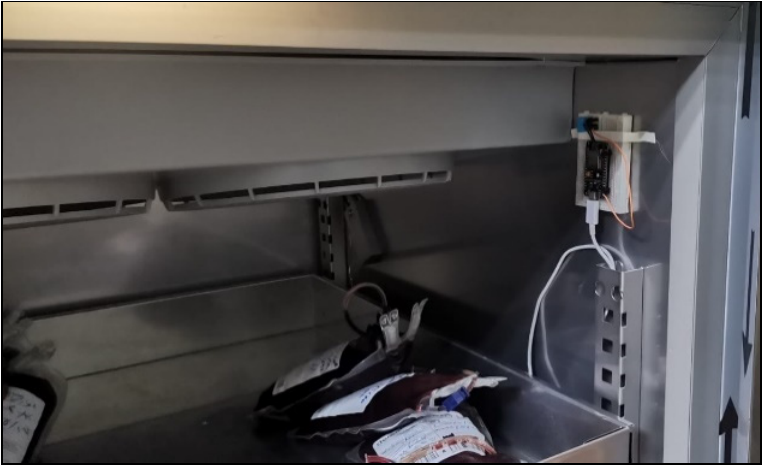
Figure 11. The connected temperature sensor inside the blood bag refrigerator.